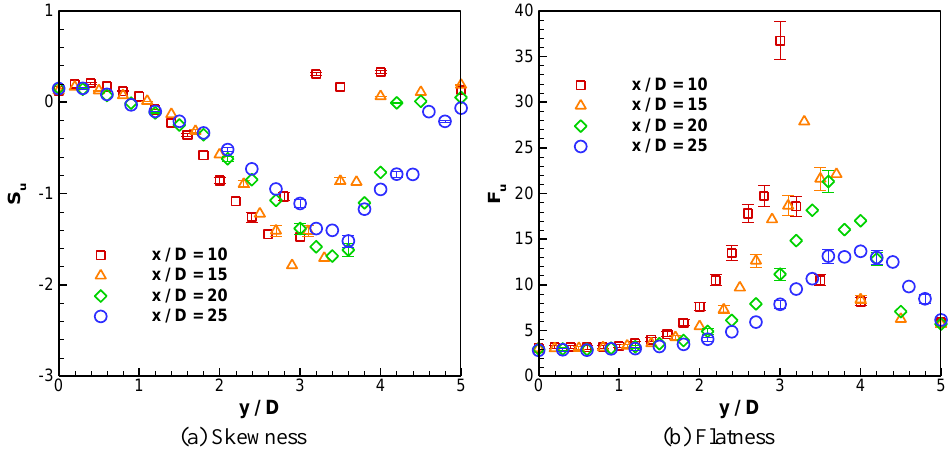
Fig. 5 Sectional distributions of skewness and flatness factors for the stream-wise component